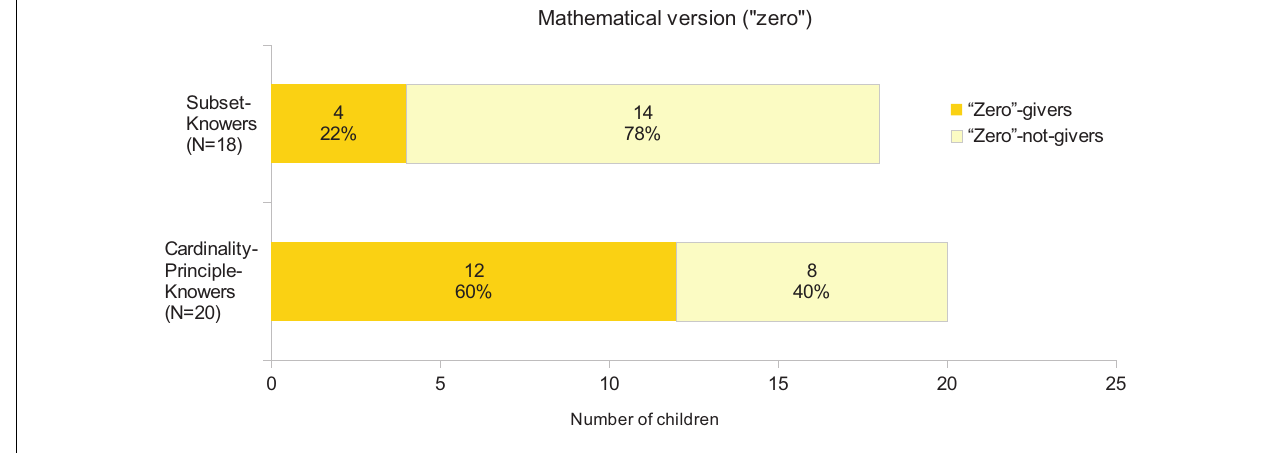
subset-knowers as reflected in the same pattern in both groups (no interaction in any of the tasks; see Table 2 ; Aim